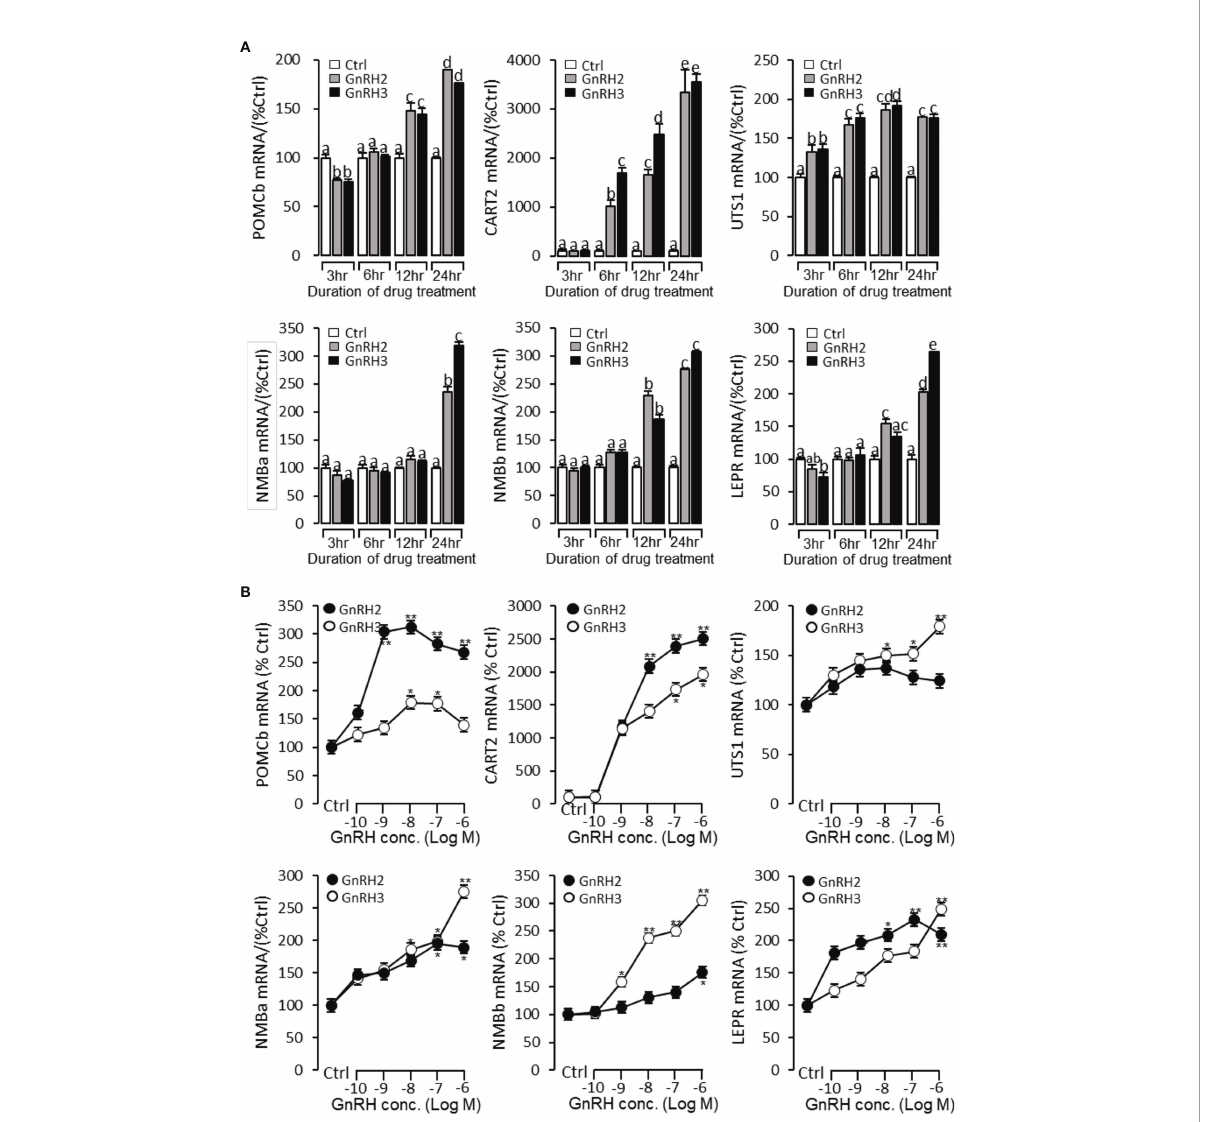
FIGURE 9 Regulation of feeding hormone gene mRNA expression by GnRH2 and GnRH3 in grass carp pituitary cells. (A) Time-course experiment of grass carp GnRH2 (1 m M) and GnRH3 (1 m M) on POMCb, CART2, UTS1, NMBa, NMBb, and LEPR mRNA expression in grass carp pituitary cells. (B) Dose dependence of a 24-h treatment with increasing levels of GnRH2 and GnRH3 (0.1 – 1,000 nM) on POMCb, CART2, UTS1, NMBa, NMBb, and LEPR mRNA expression in grass carp pituitary cells. After drug treatment, the pituitary cells were extracted to total RNA, reverse transcribed, and used for RT-PCR to detect the target genes ’ mRNA expression. Data presented are expressed as mean ± SEM. p < 0.05 ( “ * ” ) or p < 0.01 ( “ ** ” ) was used to present signi fi cant differences among each group. The different letters represent a signi fi cant difference at p < 0.05 between groups (ANOVA followed by a Dunnett